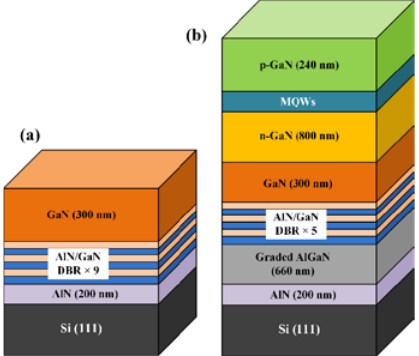
Figure 1. Structures of ( a ) samples with 9-pair AlN/GaN distributed Bragg reflectors (DBRs) and ( b ) LEDs with 5-pair AlN/GaN DBRs.